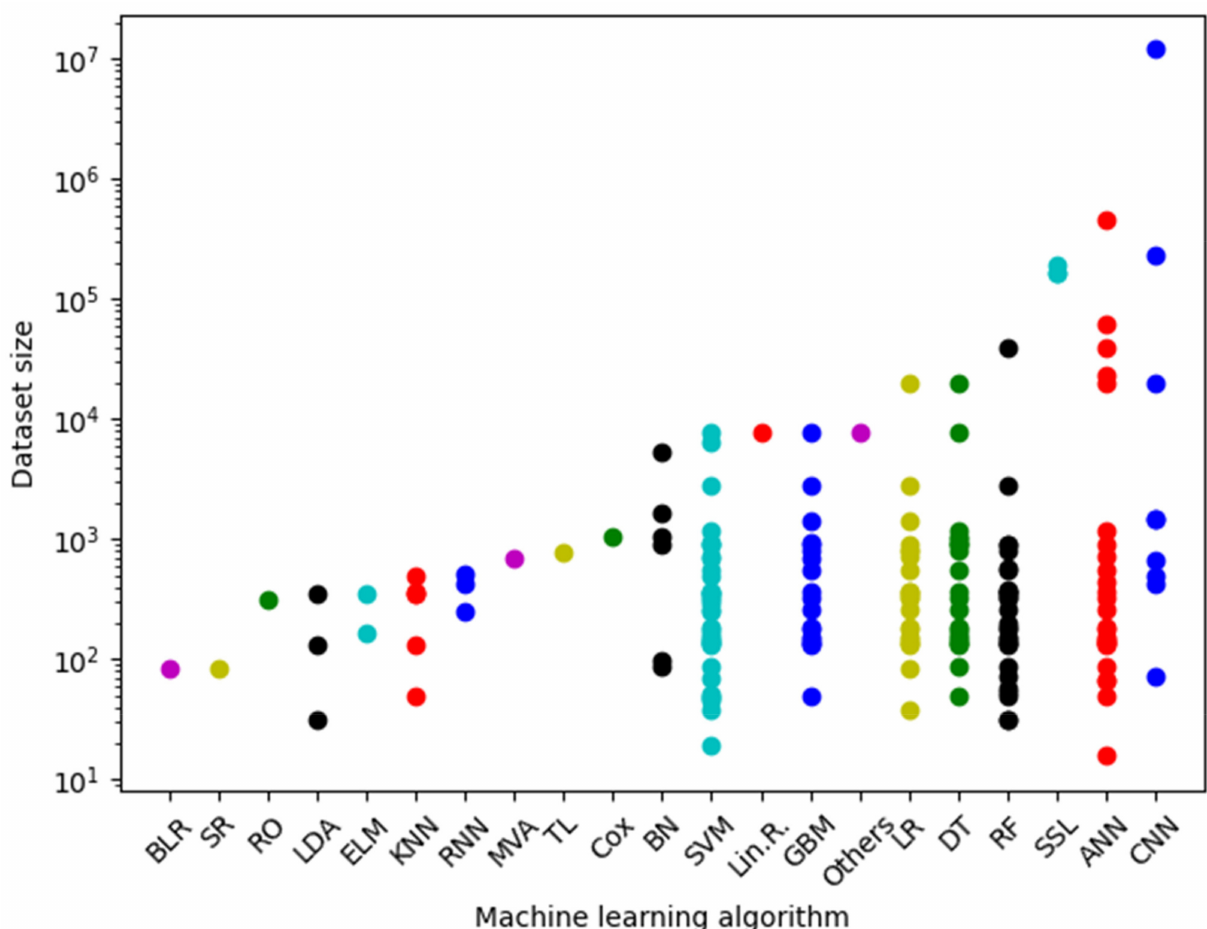
Figure 3. Reported dataset size by